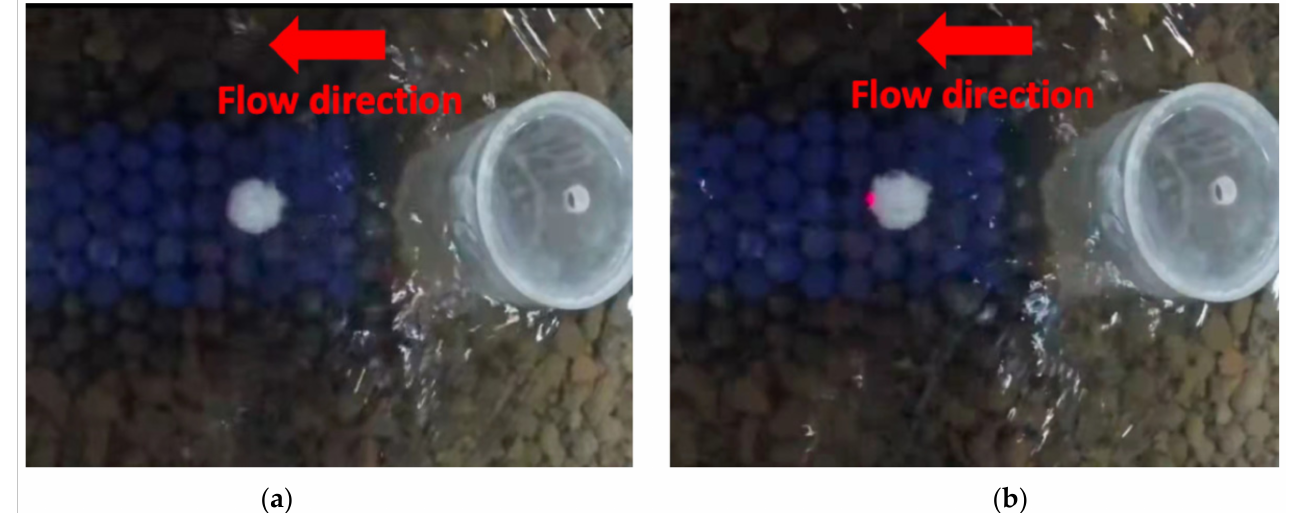
Figure 8. Photographs taken from the camera demonstrate the two main stage characteristics of the particle entrainment process; ( a ) the exposed particle in the fully displaced position (the pin restraining its downstream motion), partially covering the He-Ne laser beam which is detected by the camera; ( b ) the exposed particle remains in its resting pocket and the He-Ne laser beam is not partially targeting the particle (state of no